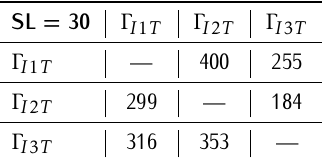
Table 7. Non-unique matching light segments between measurements for trajectory (II) Timis